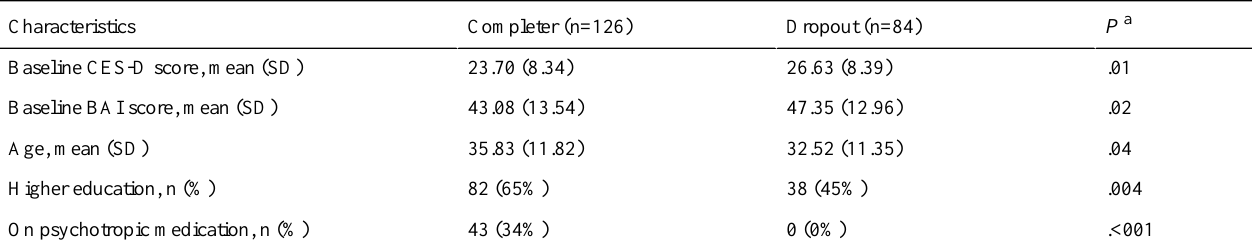
Table 2. Differences between dropouts and study completers.